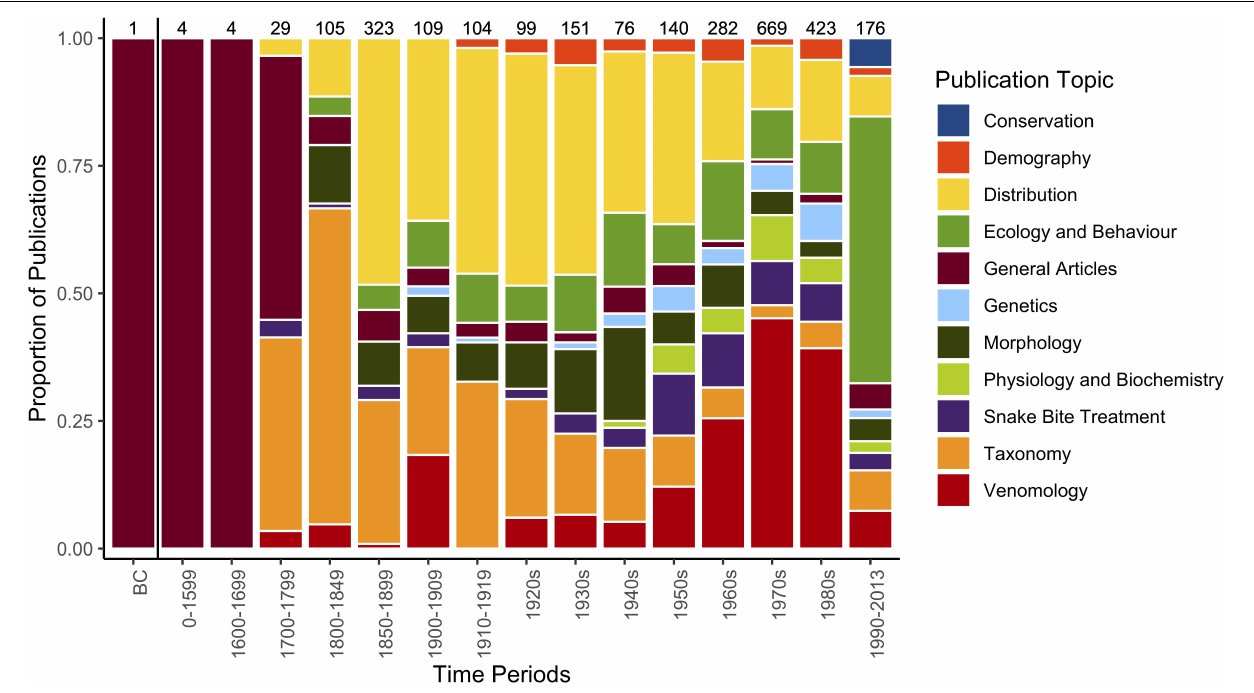
FIGURE 1 | Barplot showing the trend in number of publications focusing on marine snakes including sea snakes and sea kraits over time. Popular and semi-popular articles solely on methods are excluded. ‘Ecology’ includes natural history, trophic relationships, predators, parasites and relationship to the physical environment. ‘Morphology’ includes coloration. Numbers above bars represent publications during that time period. Figure recreated from Heatwole (2015) with permission. Data for articles prior to the 1980s were extracted from Culotta and Pickwell (1993) and composed of publications that mentioned sea snakes in any way, even if most of the article was on other taxa. Data from 1990 to 2013 are based on Heatwole (2015), who searched for articles that specifically focused on sea snakes, thereby lowering the number of